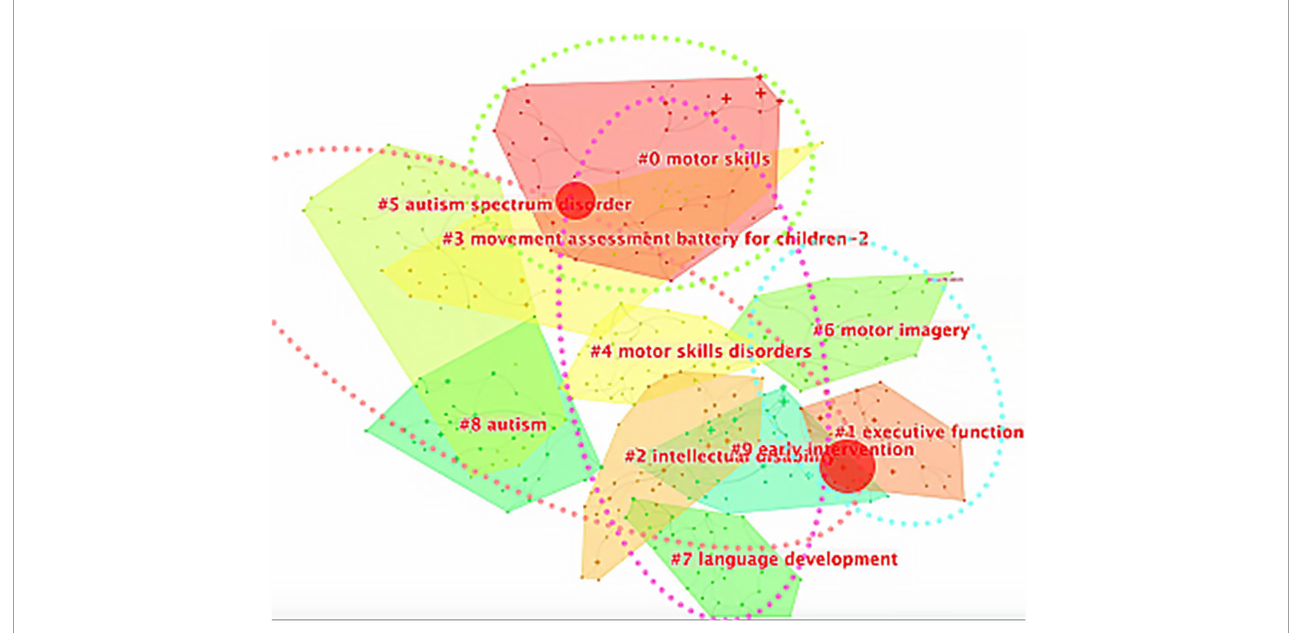
FIGURE4 Keywords cluster analysis. The blue circle is plate 1: # 1 and # 6 make up the cognitive neuroscience plate (relationship between cognitive function and process and explicit DCD); the red circle is plate 2: # 5, # 3, # 4, # 8, # 2, and # 9 constitute the medical plate (co-occurrence evaluation intervention of NDDs); the pink circle is plate 4: # 0, # 4, # 2, and # 7 constitute the psychology plate; the green circle is plate 3: # 0 is an education plate.